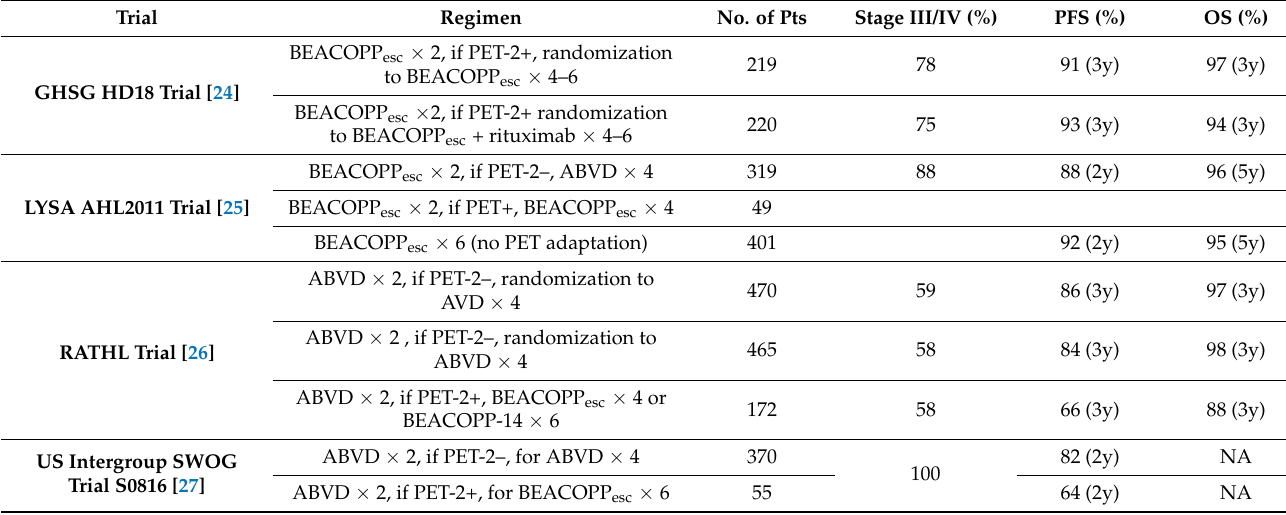
Table 3. PFS and OS in the main PET-adapted